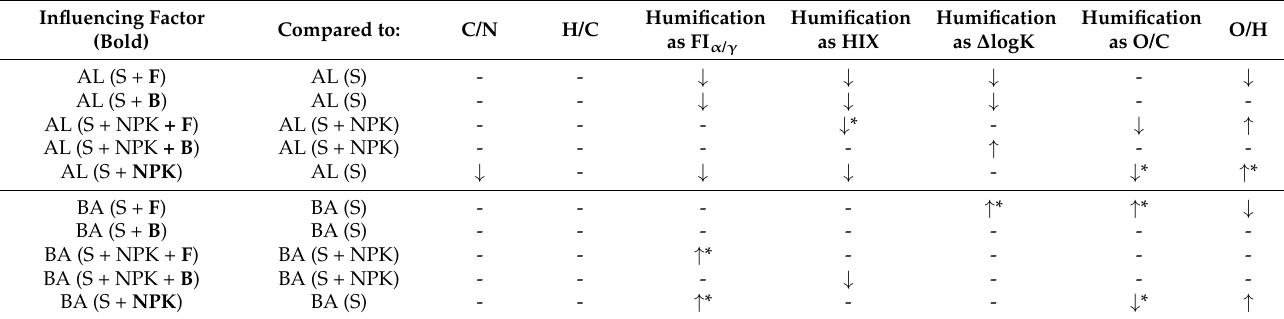
* Uncertain direction of changes, e.g., cases where a particular trend was disturbed on one of the dates. - No significant